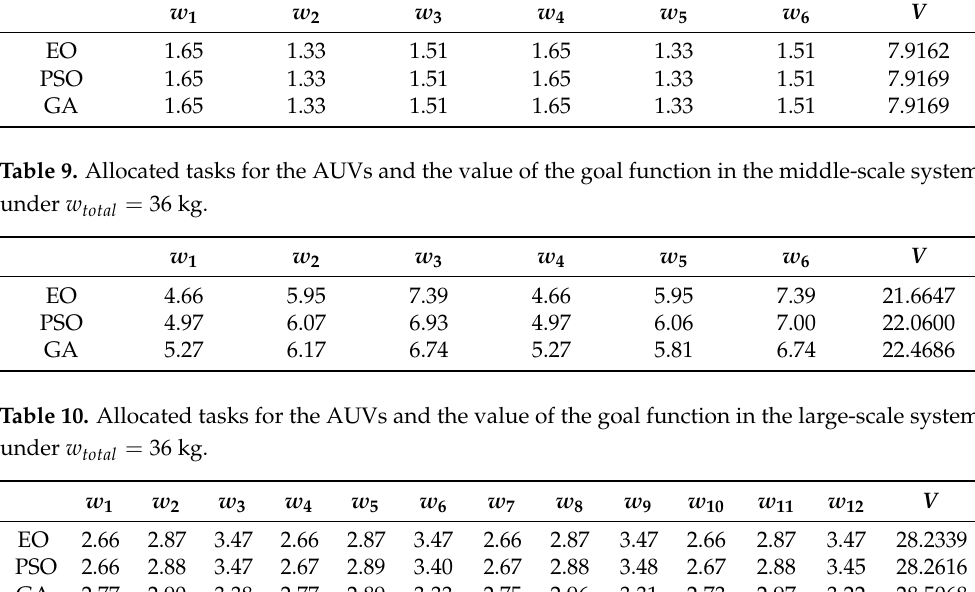
Table 8. Allocated tasks for the AUVs and the value of the goal function in the middle-scale system under w total = 9 kg. w 1 w 2 w 3